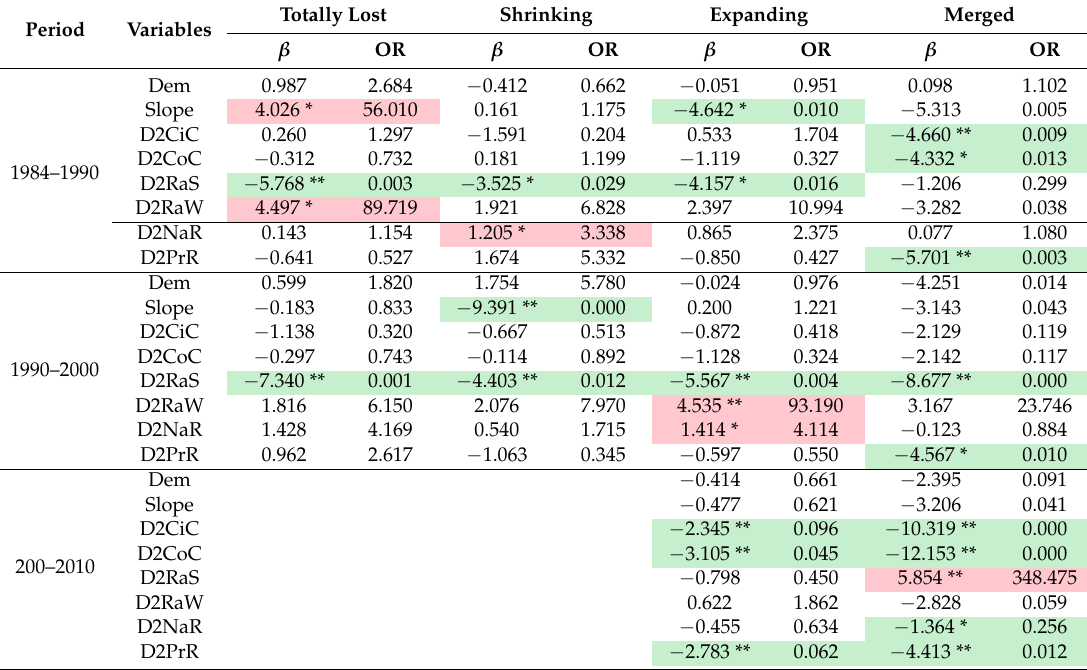
Table 7. The effects of driving factors on the changes of rural